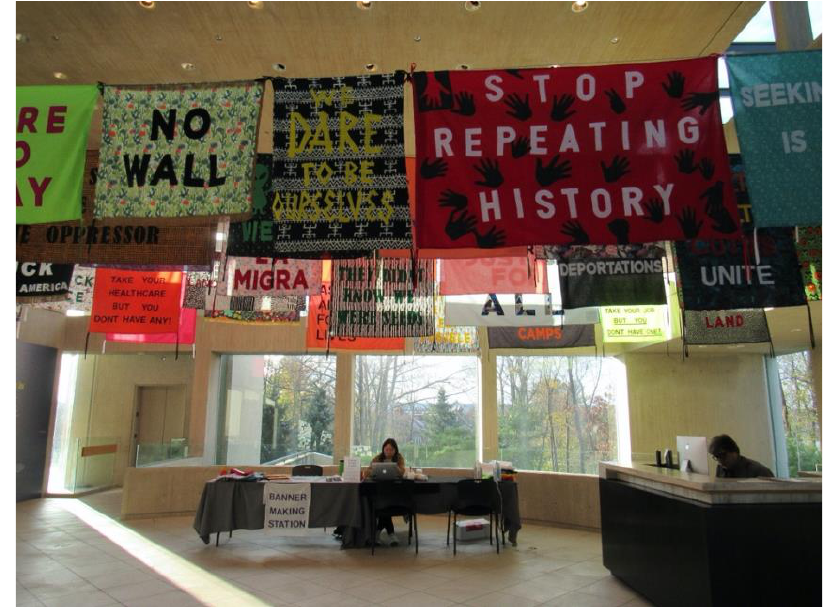
Figure 4 Aram Han Sifuentes, Protest Banner Lending Library , 2016 – ongoing. Felt and fusible web on fabric (Photo: